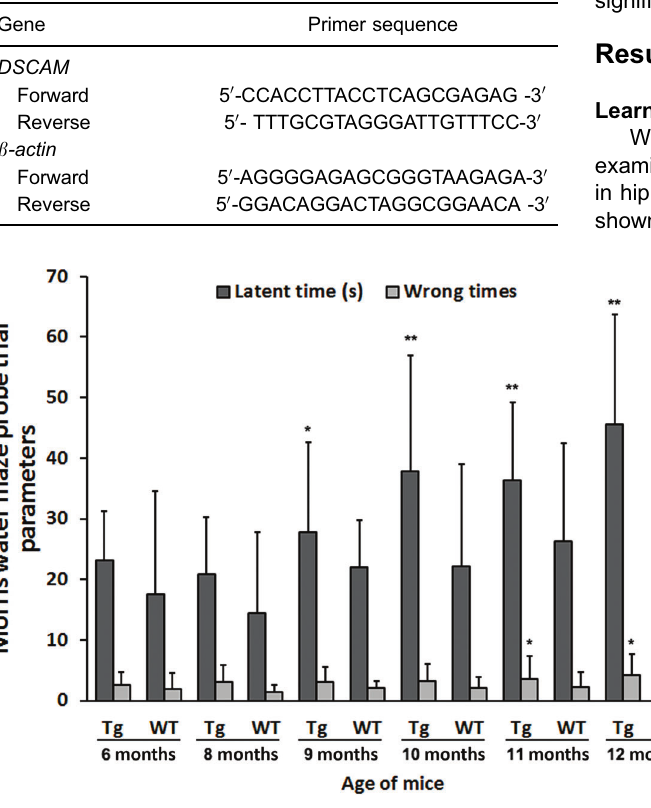
Table 1. Primer sequences.